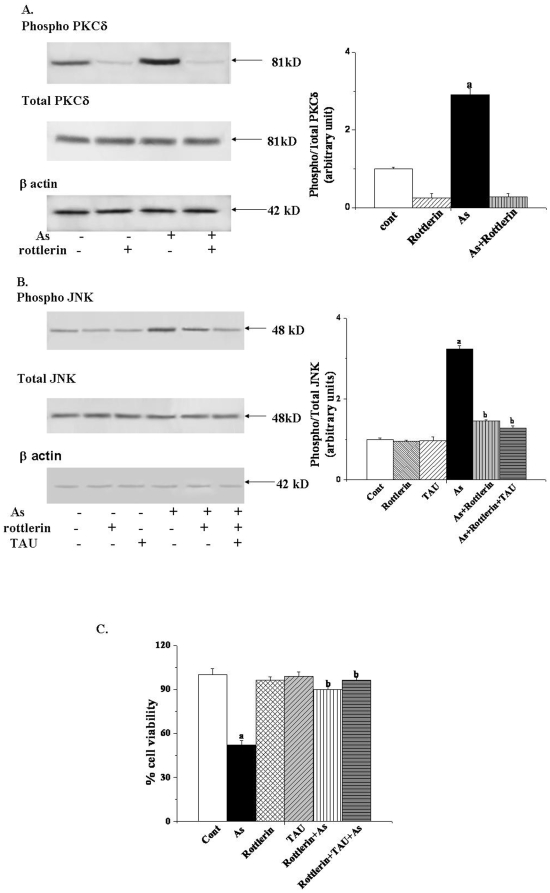
Immunoblot analysis of PKCδ, JNK and cell viability in hepatocytes in response to rottlerin.Hepatyocytes were pre-treated with 10 µM rottlerin for 30 min, then treated with As (10 µM), taurine (25 mM, added 1 h prior to As treatment) for 8 h. Panel A: effect of rottlerin on Phospho and total PKCδ, Panel B: effect of rottlerin on Phospho and total JNK, Panel C: effect of rottlerin on cell viability. β actin was used as an internal control. Data represent the average ± SD of 6 separate experiments in each group. “a” indicates the significant difference between the normal control and As treated groups, “b” indicates the significant difference between the As treated and taurine treated groups. (Pa<0.05, Pb<0.05).